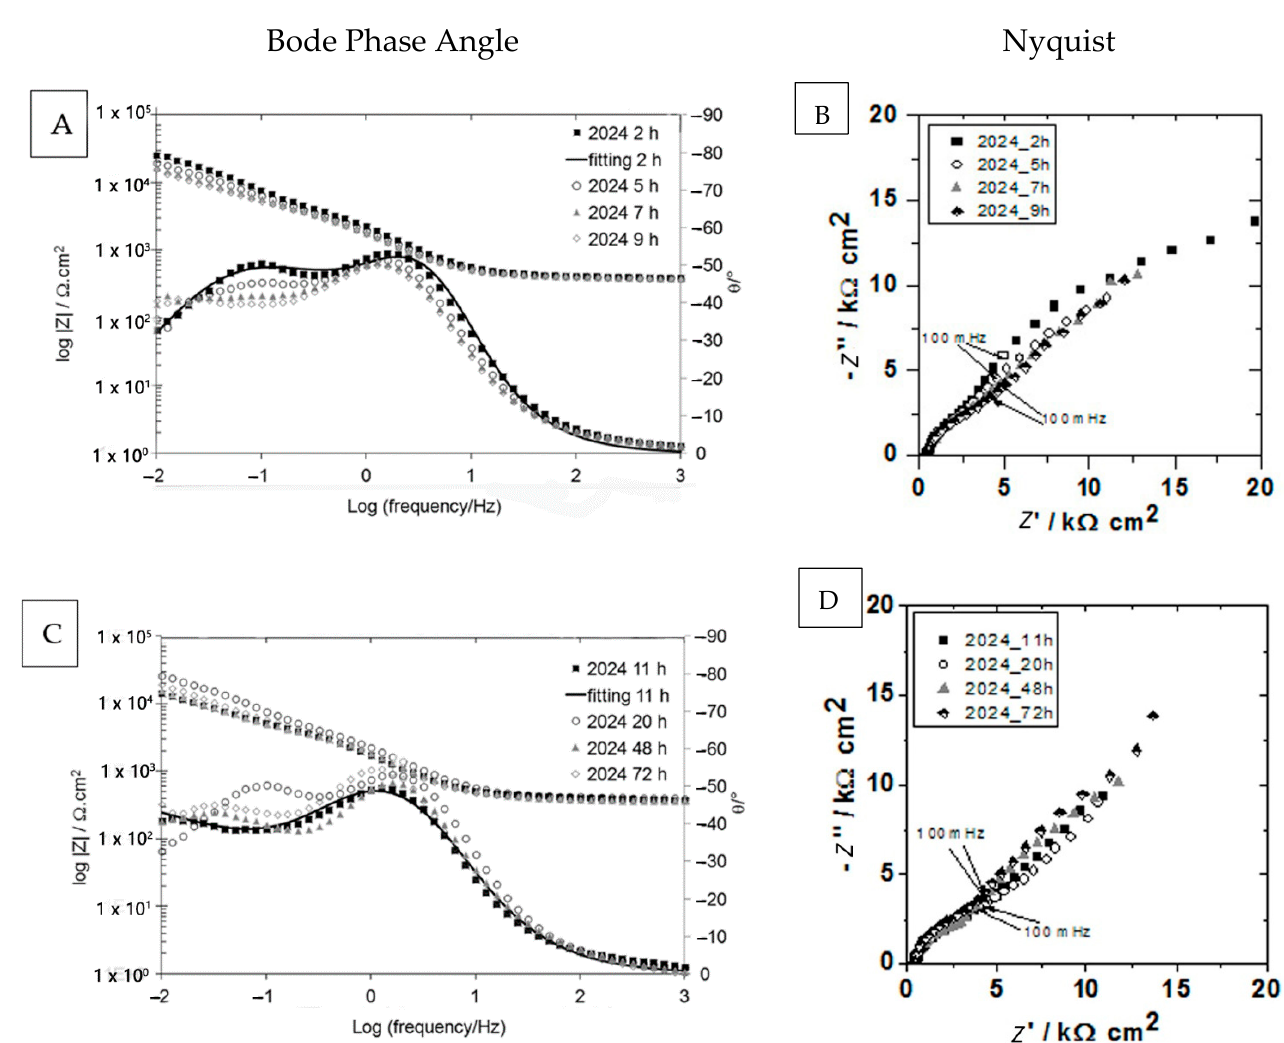
Figure 5. Evolution of EIS results for the AA2024-T3 as a function time of exposure to 0.01 mol L − 1 NaCl electrolyte. ( A ) Bode phase angle and ( B ) Nyquist diagram. Measurements were taken after 2, 5, 7 and 9 h of the experiment. ( C ) Bode phase angle and ( D ) Nyquist diagram. Measurements were taken after 11, 20, 48 and 72 h of the experiment.